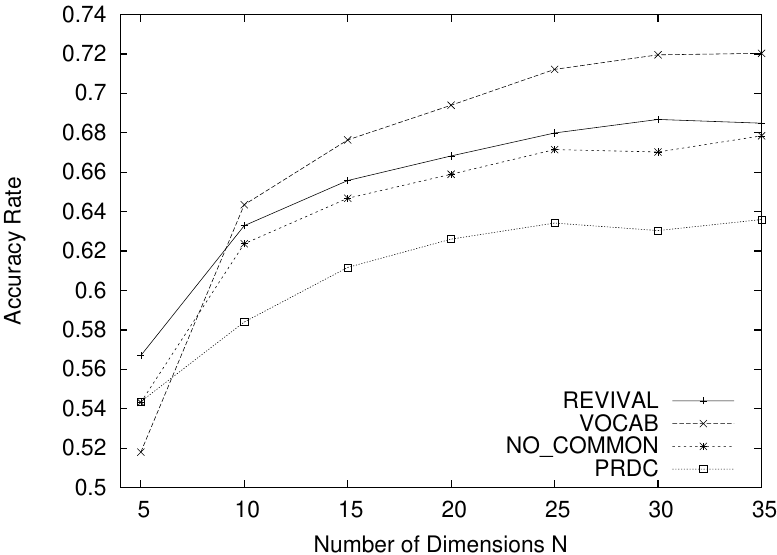
Figure 8. Accuracy rate for Wang database: PRDC.